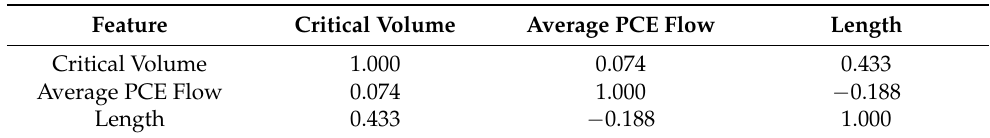
Table 1. Continuous features correlation matrix.